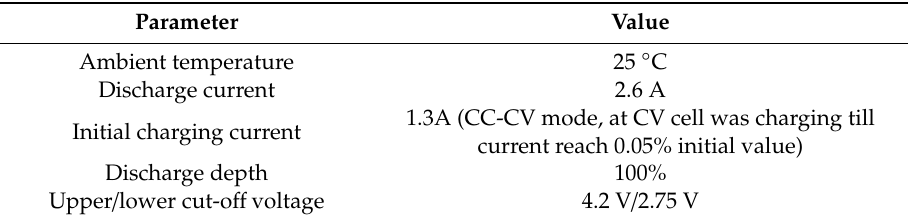
Table 3. The test conditions for measuring cell